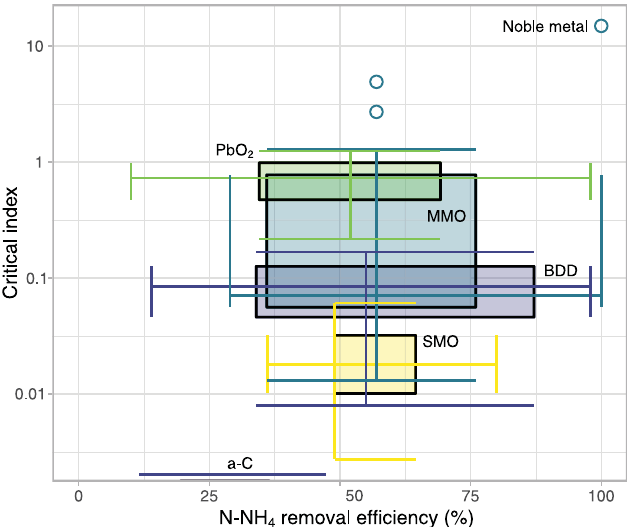
Fig. 7. Correlation between the material critical index and N- NH4 removal ef fi